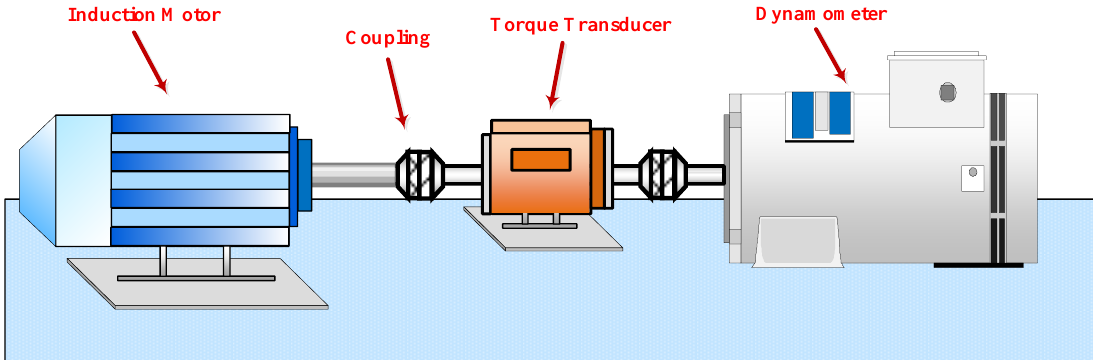
Figure 5. The experimental platform of CWRU.